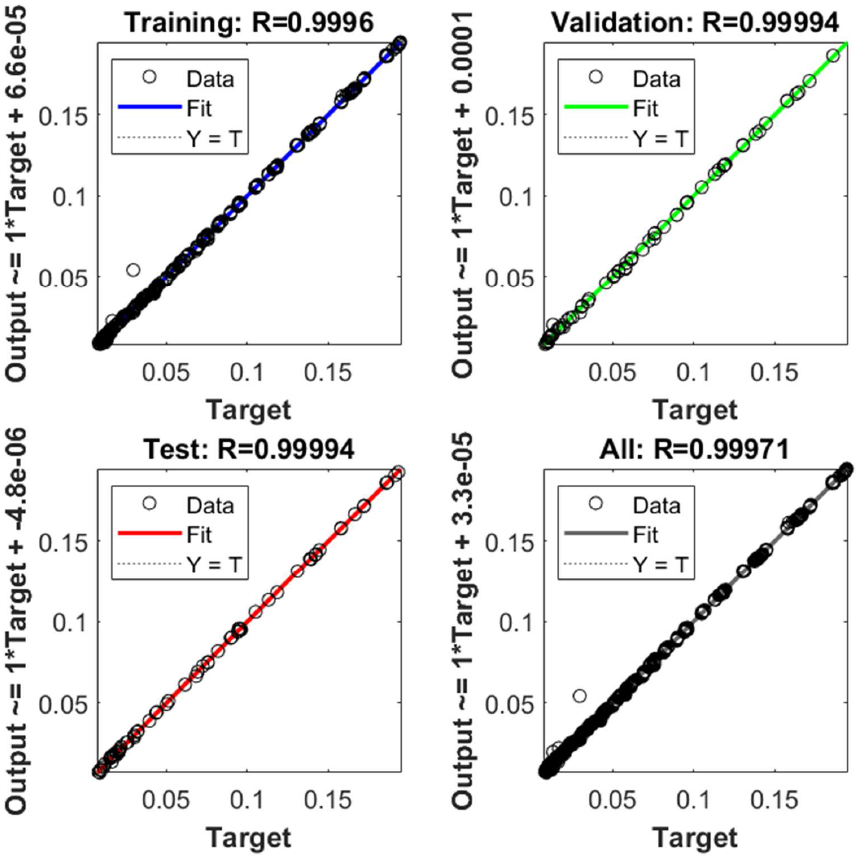
Figure 8. Regression plot for the best RMSE case.